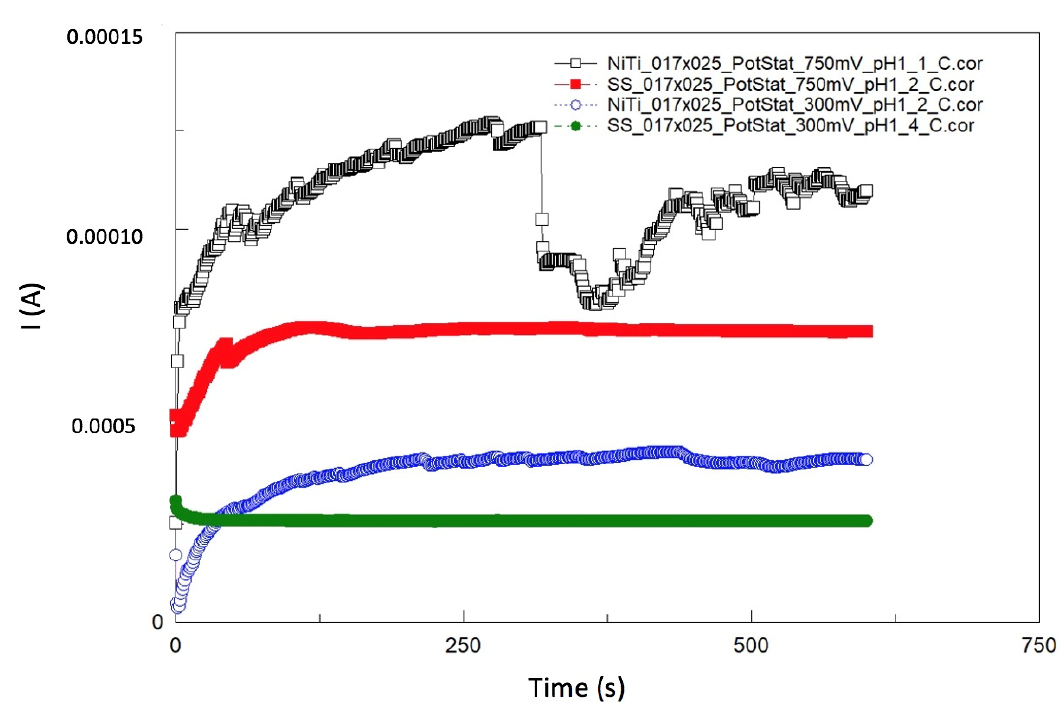
Figure 13. I vs. t curves of NiTi and SS wires during polarization with 300 mV and 750 mV versus OCP for simulation of oxidation in Ringer’s solution at pH = 1 (RT). Table 6. Summary of charges (Q) and the calculated mean metal ion mass from Figure 13.